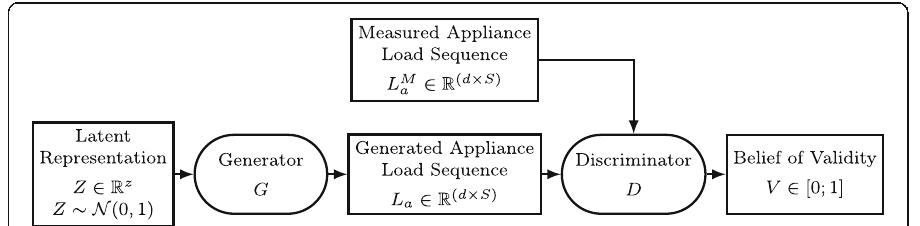
Fig. 3 A Generative Adversarial Network to generate appliance load